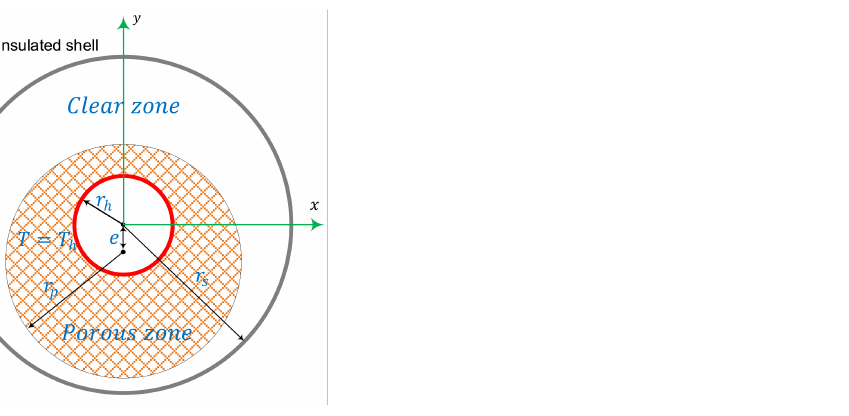
Figure 1. ( a ) Schematic representation of the three-dimensional thermal storage unit; and ( b ) the cross-section of the energy storage unit (and the computational